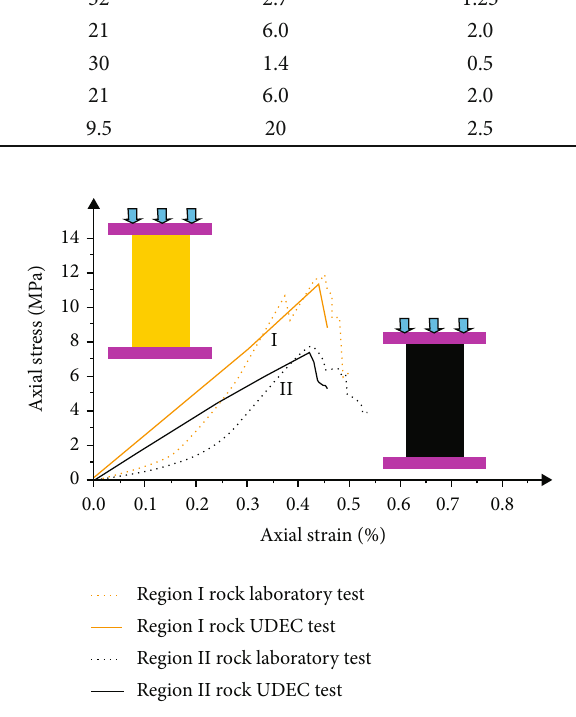
Figure 8: Comparison of stress-strain curves obtained from simulation and test on roof rock in I and II